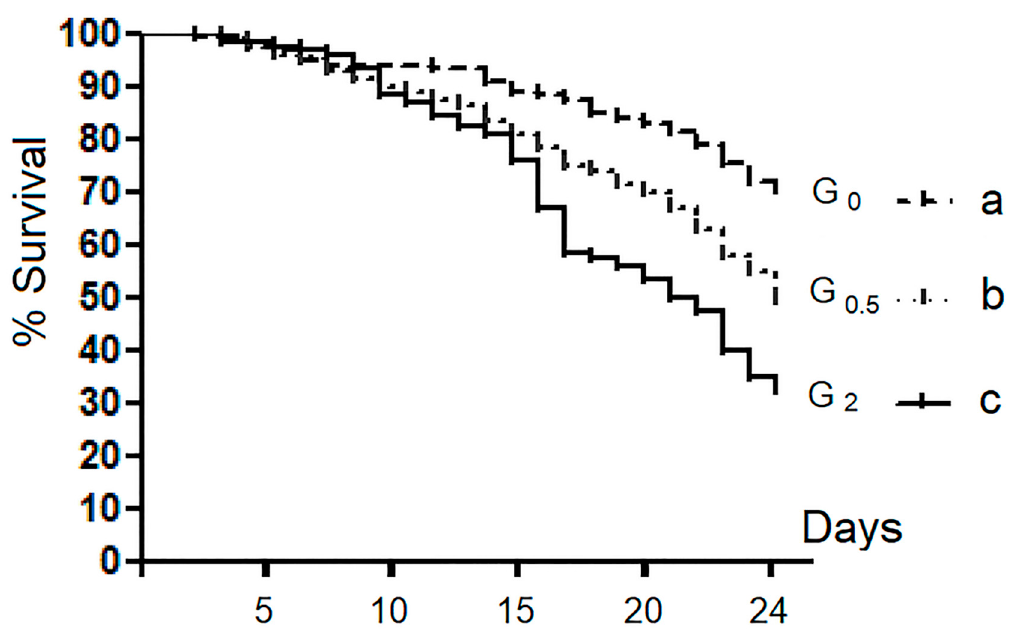
Figure 1. Survival curves: comparison among groups. Each curve indicates the sum of four replicates for the group. In G 0 , G 0.5 , and G 2 , are grouped bees fed with 0%, 0.5%, and 2% of 1,3-1,6 β -glucans (w / w) in syrup, respectively. Di ff erent letters show statistically significant di ff erences ( p < 0.01).